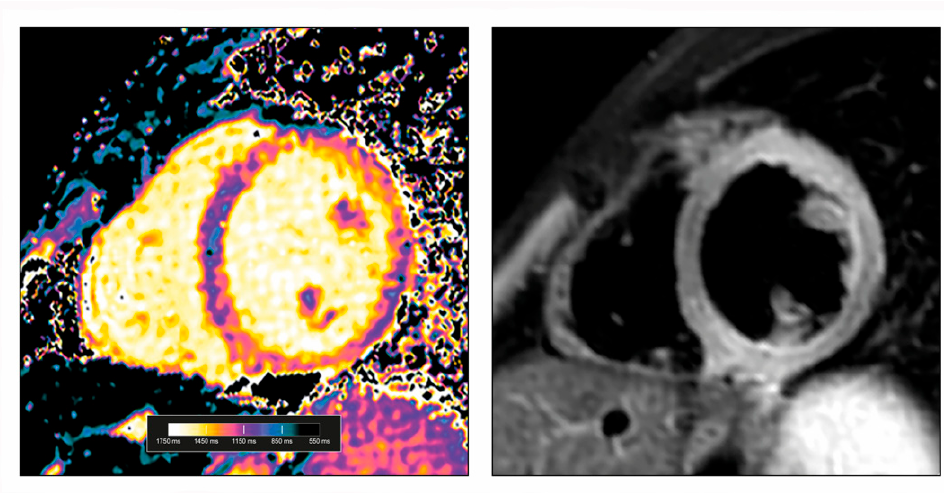
Figure 1. Native T1 map ( left ) in a patient with acute myocarditis showing prolonged T1 relaxation times in the anterolateral and inferoseptal regions of the left ventricle (1320 ± 43 ms (local reference 999 ± 31 ms)). Corresponding T2-weighted black blood short tau inversion recovery sequence ( right ) with clear signs of oedema in the same regions.